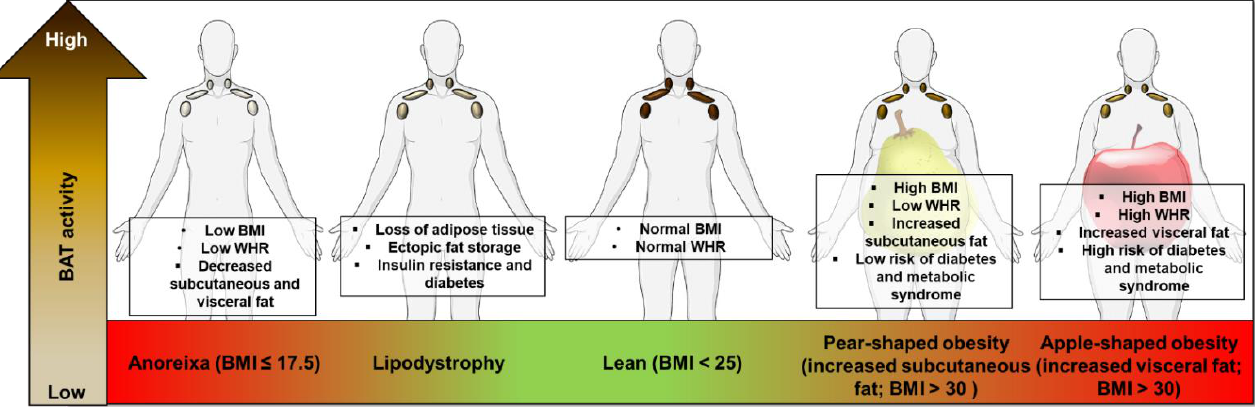
Figure 2. Summary of the impact of undernutrition, overnutrition and altered fat distribution on BAT function. BAT activity is decreased in disorders of both reduced and excessive WAT mass compared with normal weight individuals. Fat distribution may also regulate BAT function, for example central (apple-shaped) obesity may impair BAT activity to a greater extent than those with predominant peripheral (pear-shaped) obesity. In addition, lipodystrophy syndromes are associated with reduced BAT function. Brown adipose tissue (BAT), white adipose tissue (WAT), Body mass index (BMI), waist-hip-ratio (WHR).